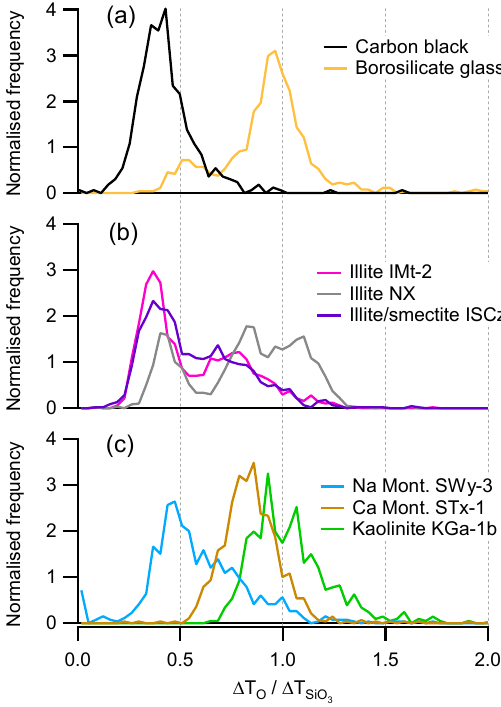
Figure 8. Histograms of the ion arrival times shift ratio ( τ ) of the el- emental ion O − and the molecular ion SiO 3 − . (a) Borosilicate glass and carbon black (carbon black calculated from the (cid:49)T C /(cid:49)T C tio). (b) Potassium-rich illite containing samples and (c) Na- and Ca-rich samples of montmorillonite and kaolinite.